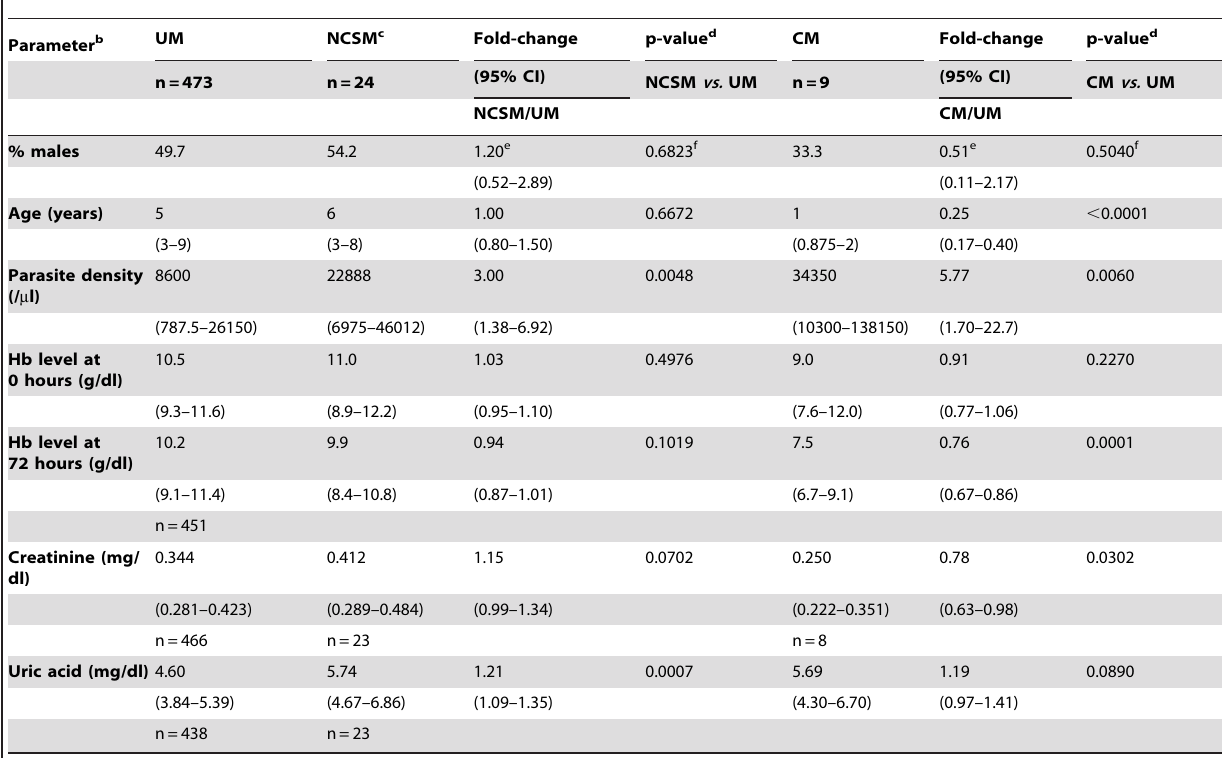
Table 1. Demographic, parasitological and biochemical parameters, stratified by clinical presentation.